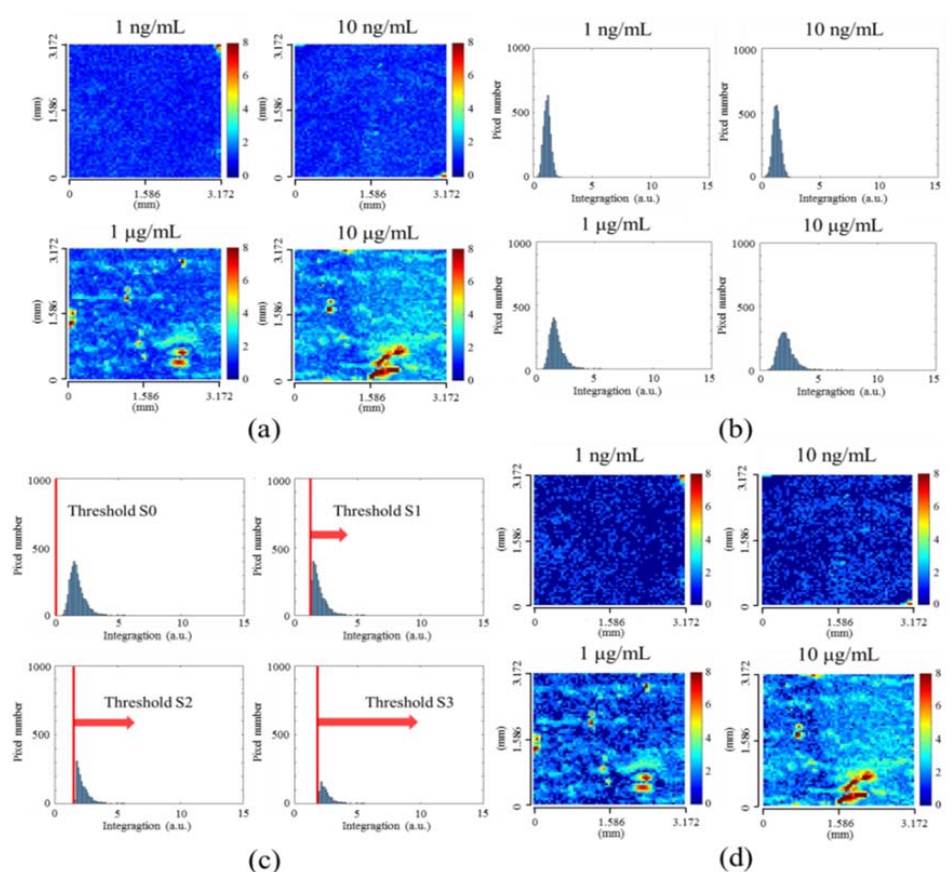
Figure 5. Anti-BSA concentration with 1 ng, 10 ng, 100 ng, 1 μ g and 10 μ g/mL flowed after BSA immobilization. ( a ) The SPR image showed the distribution in the effective area. ( b ) The histograms of R ( x , y ) were calculated by spectral integration analysis (SIA) at different anti-BSA concentration. ( c ) The modified histograms with different threshold values, with the average plus 0(S0), 1(S1), 2(S2), and 3(S3) times standard deviations of the control experiments. The x-axis and y-axis shown in ( b , c ) are the integration response R and the number of pixels. ( d ) By eliminating the background noise, the contrast of SPR images become more pronounced at low anti-BSA concentration, respectively.